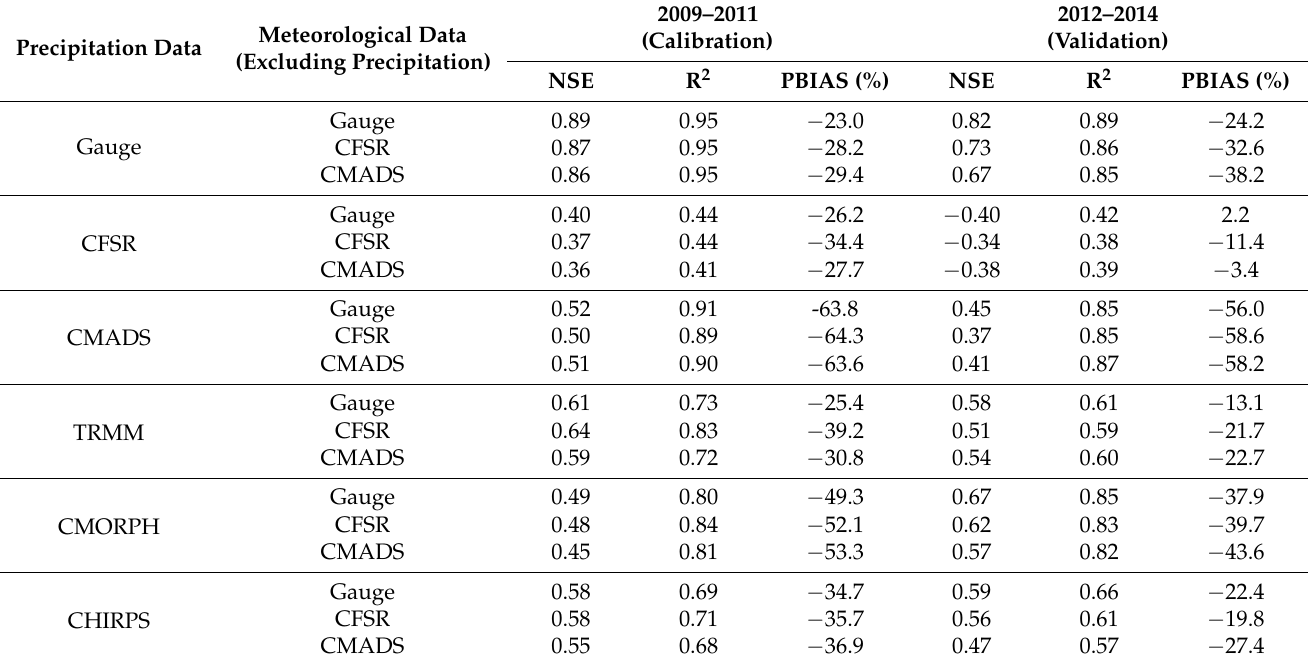
Table 3. Evaluation statistics for the performance of eighteen scenarios in monthly streamflow